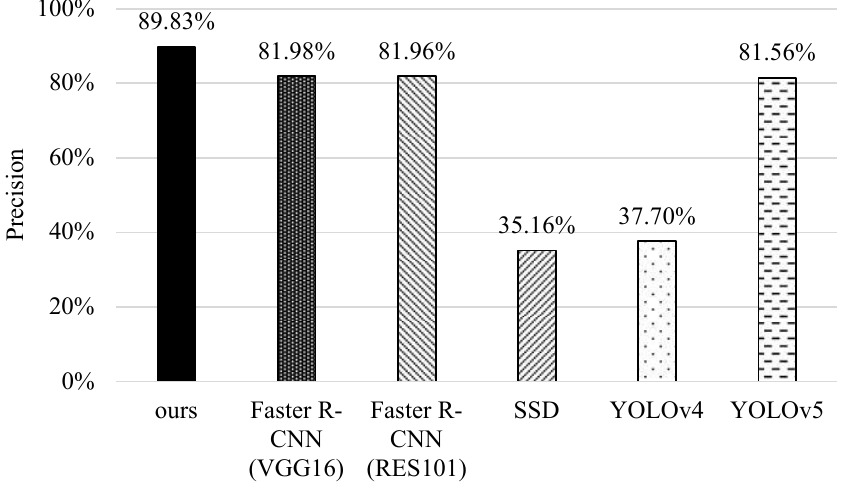
Figure 13. Comparisons of the precision of different methods.